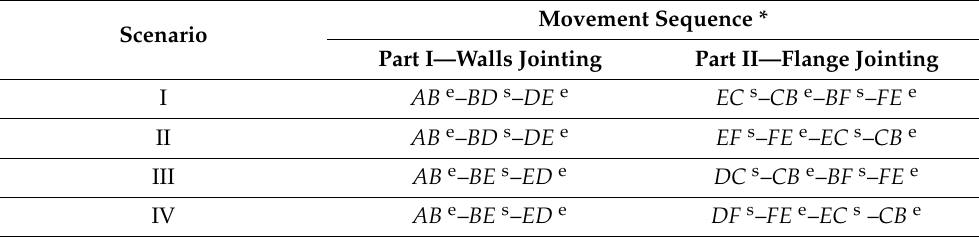
Table 1. Possible scenarios of the work of the welding